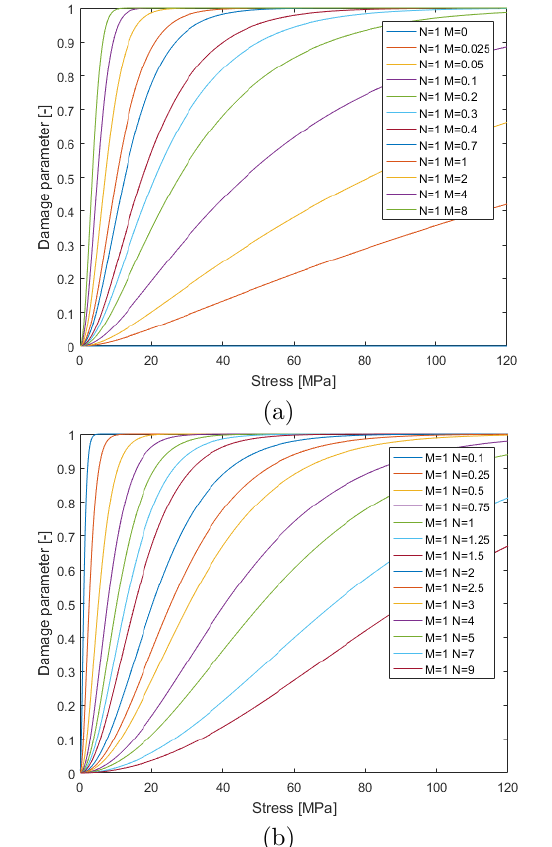
Figure 9. Influence of parameters M, N in describ- ing the evolution of ω according to Eq. (14): (a) influ- ence of parameter M , N =1, (b) influence of parame- ter N , M =1.